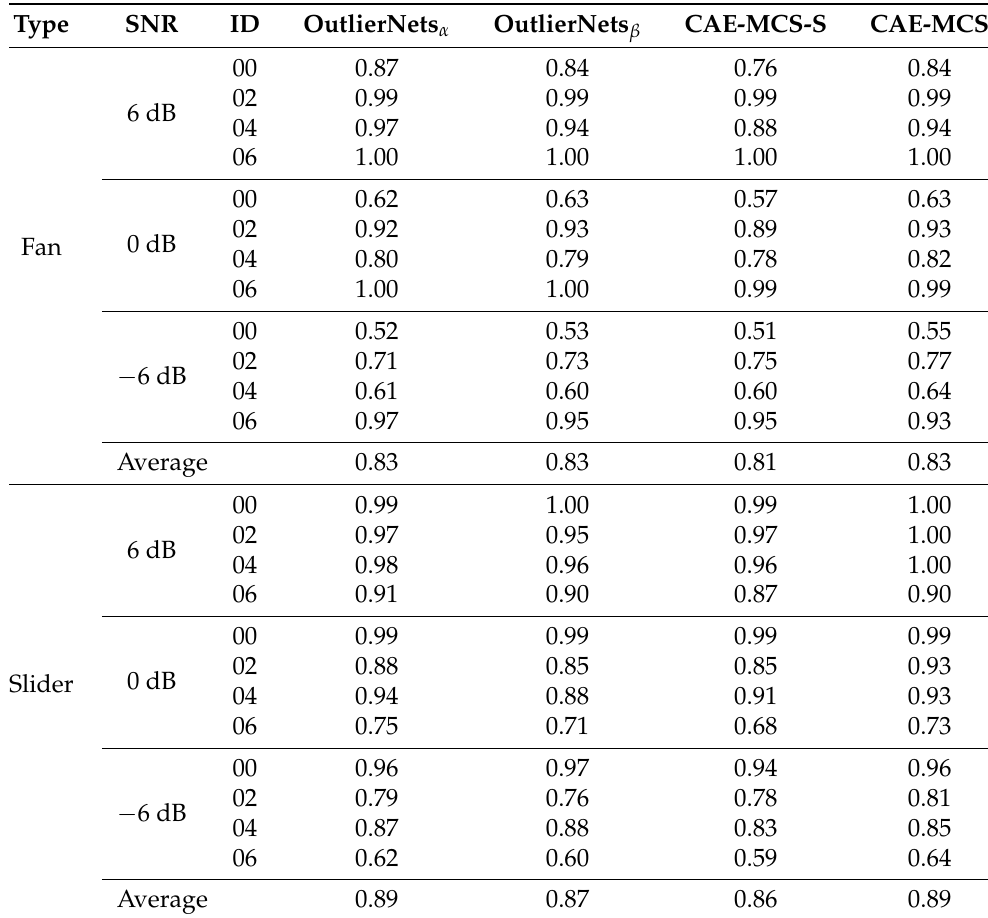
Table 3. Anomaly detection accuracy (AUC) comparison between OutlierNets α , OutlierNets β archi- tectures, CAE-MCS-S and CAE-MCS [2]. The models are evaluated on the Fan Machine and Slider Machine from the MIMII